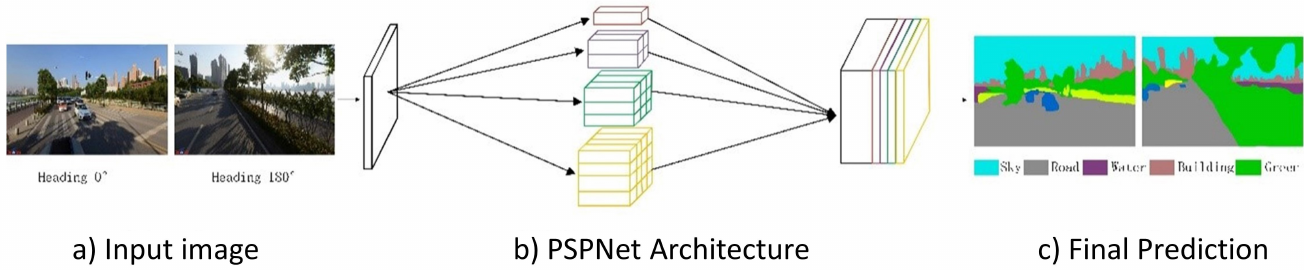
Figure 8. Schematic diagram of PSPNet